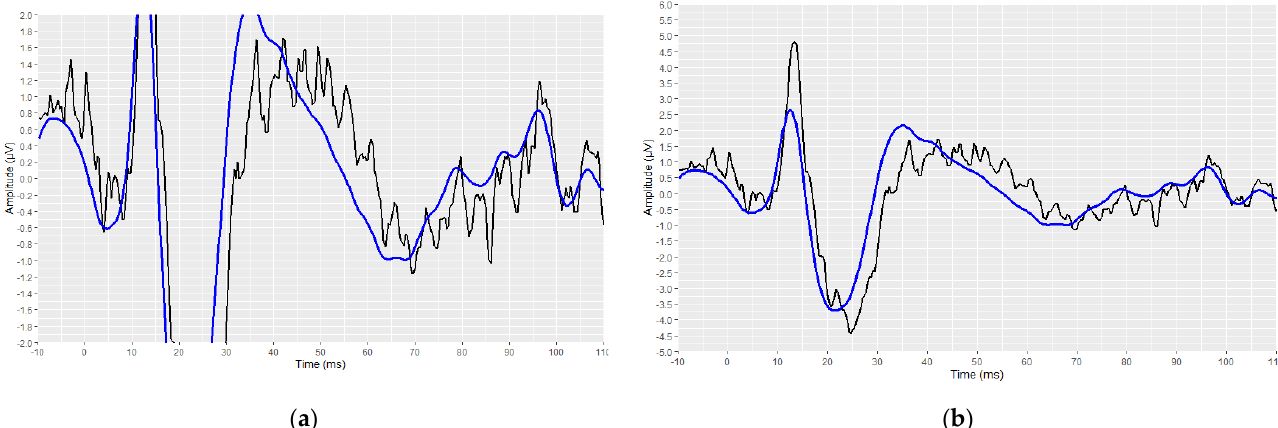
Figure 14. An illustration of a waveform in which a PAM artefact has been recorded: ( a ) the scale that has been used on the y-axis for the AMLRs plotting is also applied here; ( b ) visualization of the same waveform with a modified scale on the y-axis, to demonstrate the entire signal (raw signal is depicted in black and filtered signal is depicted in blue).